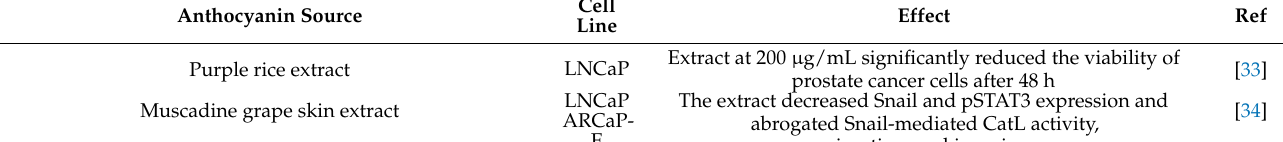
Table 1. In vitro anti-tumor assessments of anthocyanidins/anthocyanins in pure forms and in plant rich extracts towards prostate cancer